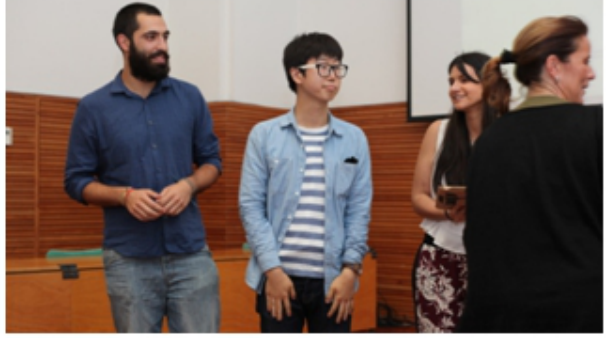
Figure 7. E4SD: Best group work